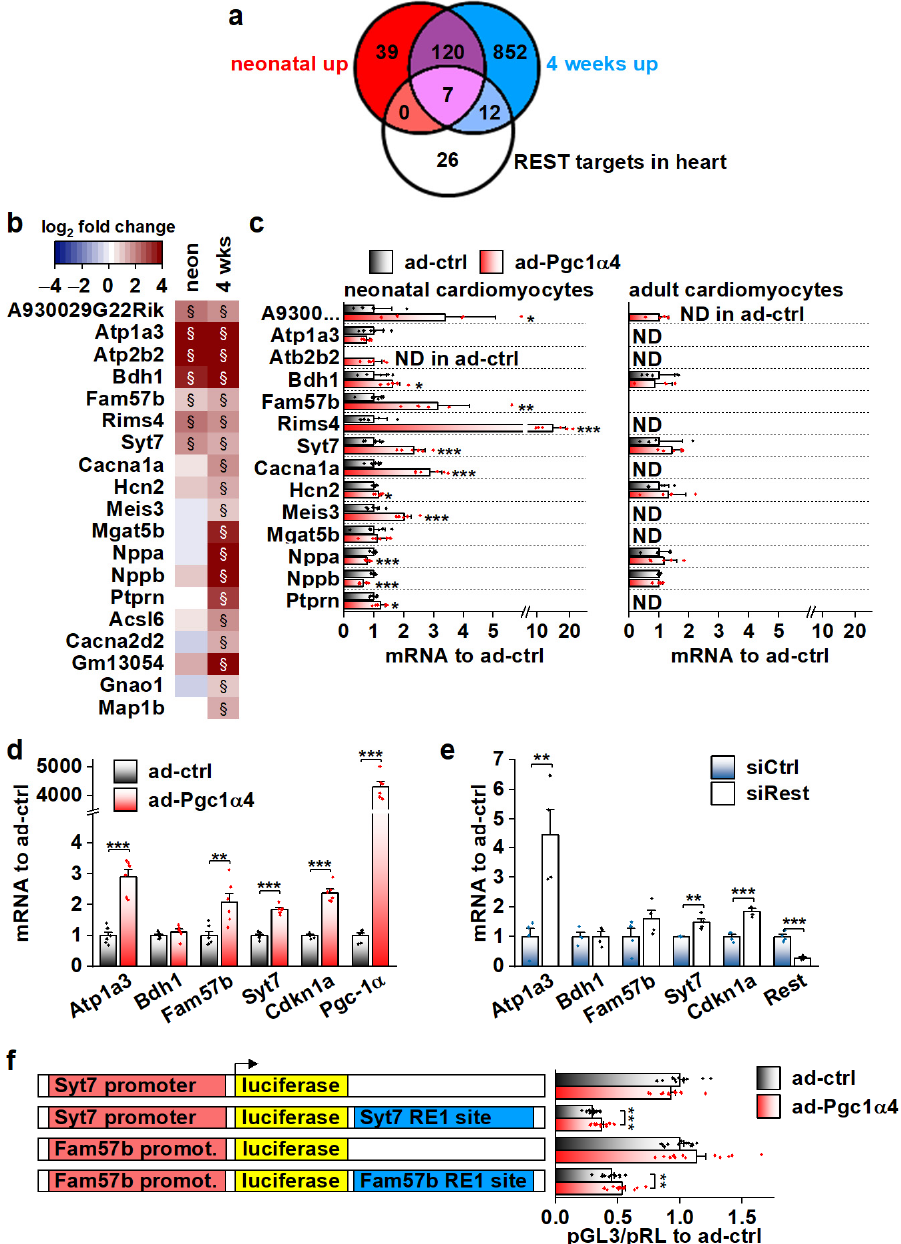
Figure 6. Genes associated with transcriptional repressor REST are induced by PGC-1 α 4 in cardiac myocytes. ( a ) Venn diagram showing the overlap of REST target genes with genes upregulated in α 4 + ventricles. ( b ) Heatmap showing log2 fold change of REST target genes in comparison to control in neonatal and 4-week-old α 4 + ventricles ( n = 4). Please note that genes with absolute log 2 fold change below 1 were not included in enrichment analyses in panel a. ( c ) Gene expression of REST target genes in cultured neonatal and adult cardiomyocytes transduced with PGC-1 α 4 adenovirus ( n [adeno neon] = 5–6, n [adeno adult] = 4–5). ( d ) Gene expression of selected REST target genes in adenoviral PGC-1 α 4 transduced HL-1 cells ( n = 6). ( e ) Gene expression of selected REST target genes in REST siRNA-treated HL-1 cells ( n = 4). ( f ) Luciferase activity in adenoviral PGC-1 α 4 transduced HL-1 cells transfected with pGL3-basic plasmids containing endogenous Syt7 and Fam57b promoters upstream and with corresponding RE1 sites downstream of luciferase ( n = 12 from 3 independent experiments). Student’s t -test p -value (or hierarchical statistical test p -value in panel f): *, p < 0.05; **, p < 0.01; ***, p < 0.001. Heatmap: §, DESeq2 analysis p -value p < 0.01 and absolute log 2 fold change >1.